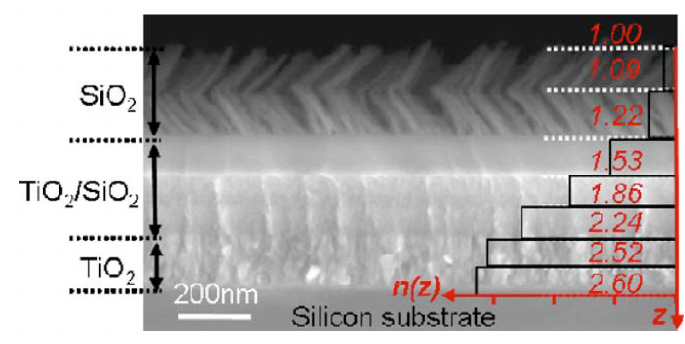
Figure 18. SEM image of a seven layered thin film ARC produced and modeled by Kuo et al . [61] using TMM. Reprinted with permission from reference [61], Copyright 2008 Optical Society of